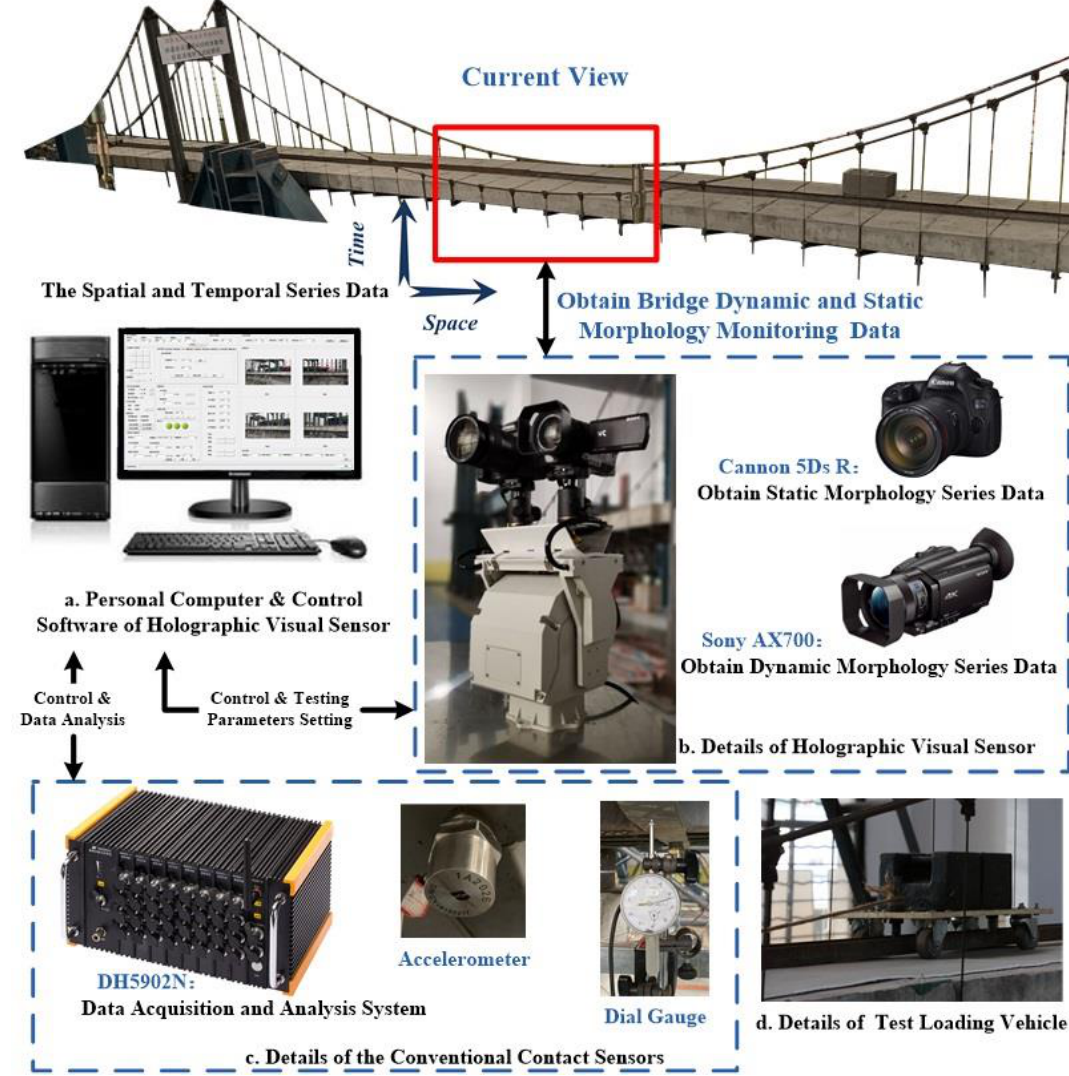
Figure 10. The device of experiments. Table 1. Test conditions and content.